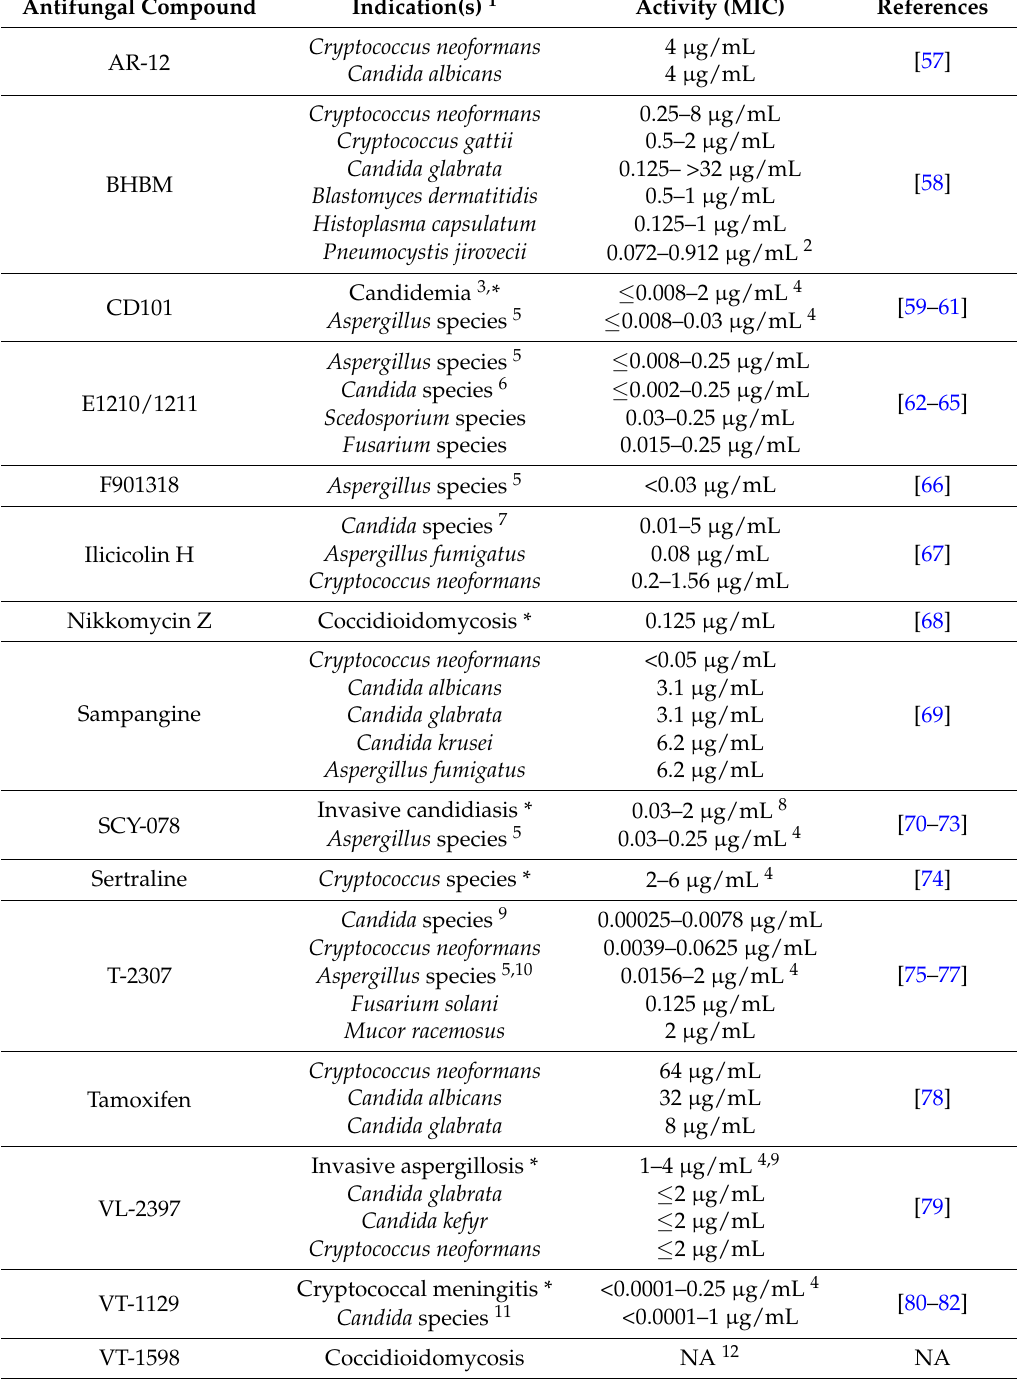
Table 4. New antifungal agents in